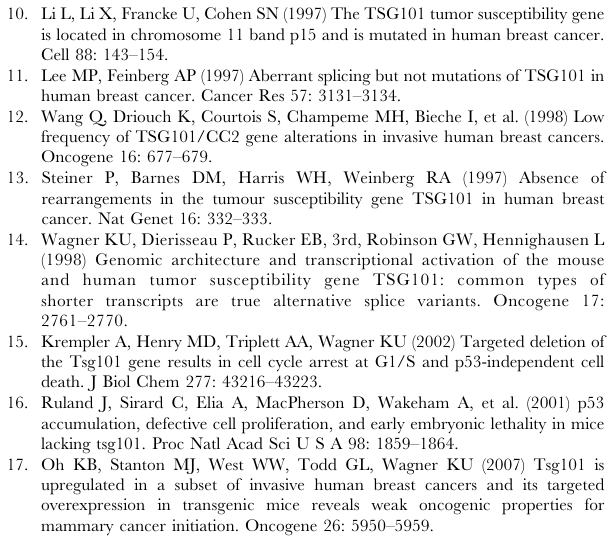
Figure S1 Rates of death in ept/tsg101 mutant eye-antennal clones. A clone of ept/tsg101 mutant cells in the eye disc marked by the absence of GFP (green) stain brightly for the cleaved, activated form of Caspase-3